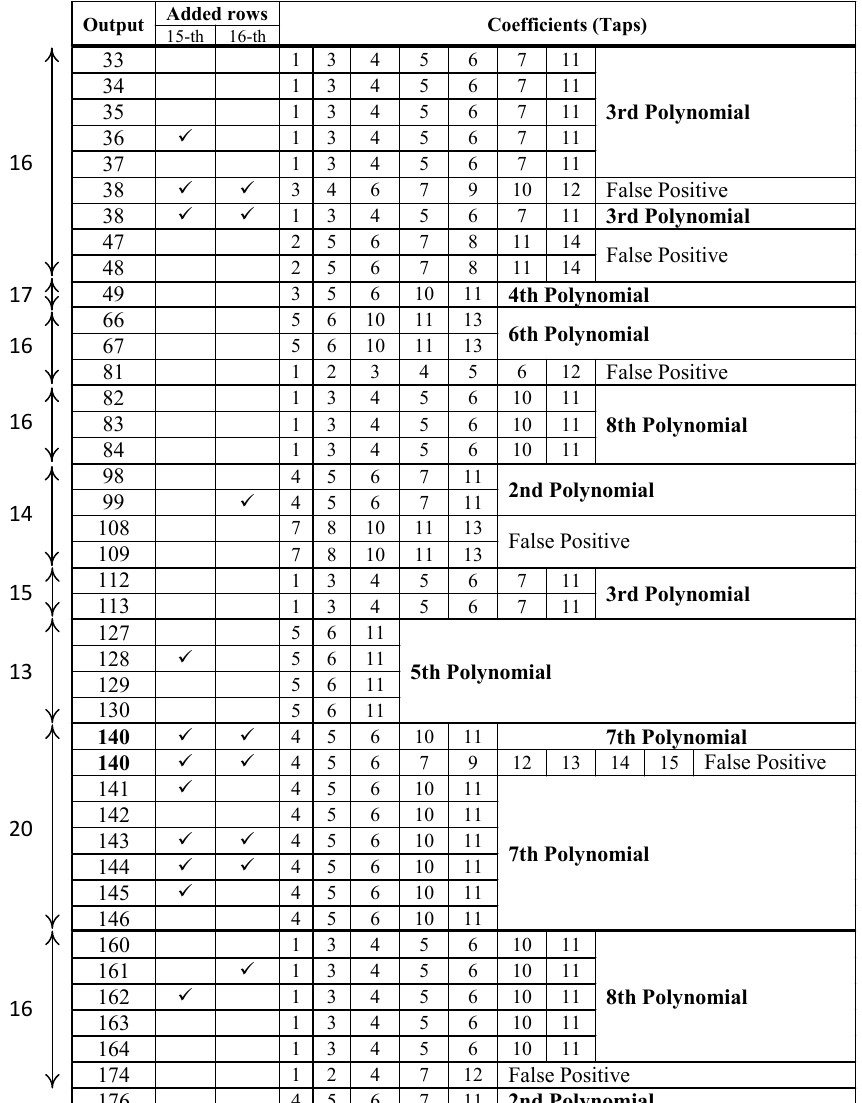
Figure 3. Example of the results of the